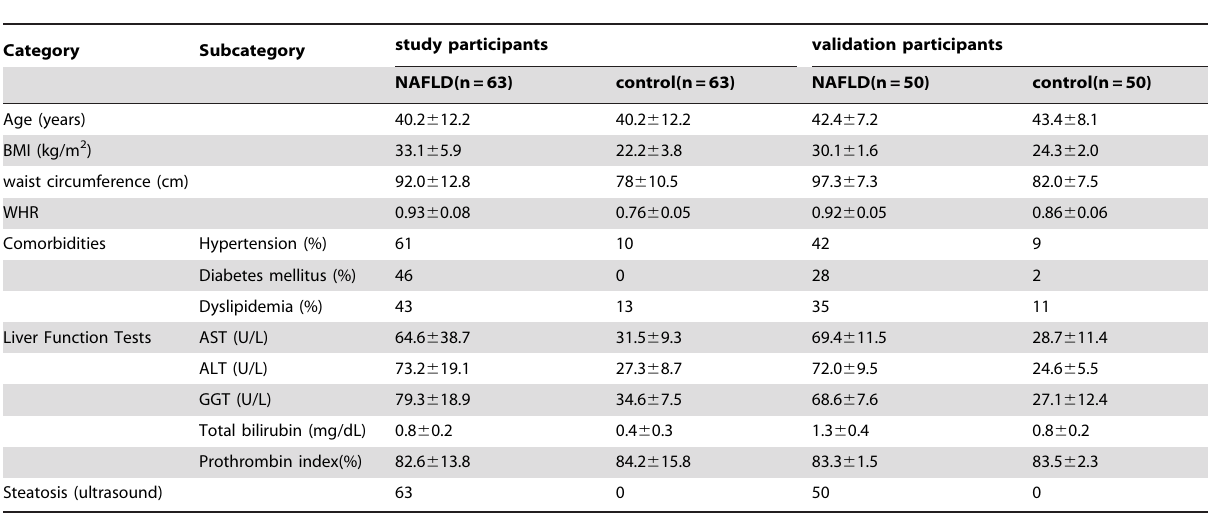
Table 2. Clinical and liver features of the study participants and the validation